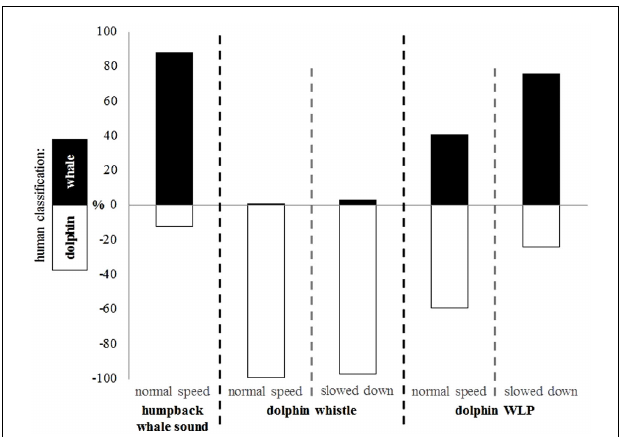
FIGURE 3 | Human evaluation of humpback whale sounds, dolphin whistles, and dolphinWLPs broadcast at different speeds. The classification is given in percent.The upper part (black) represents the classification of sounds as being produced by a whale; the lower part (white) represents the classification of sounds as being produced by a